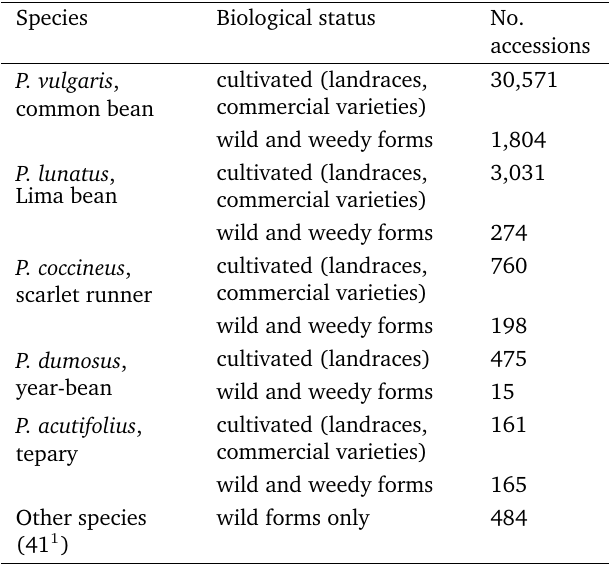
Table 1. Accessions of the in-trust Phaseolus collection kept at CIAT Palmira (information also available in Genesys: https://